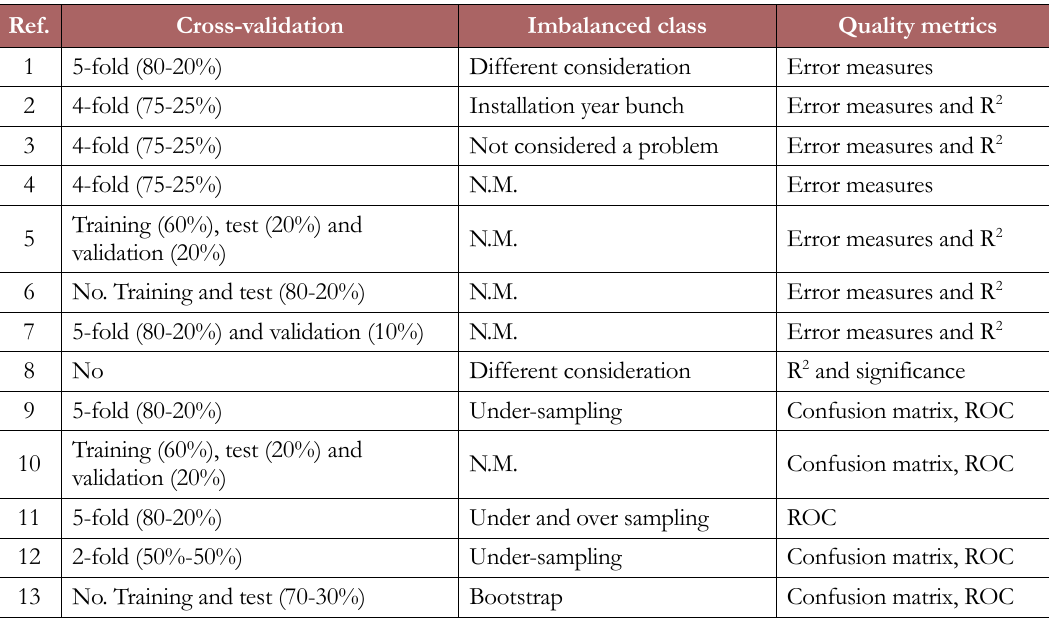
Table 3. Aspects of the training and validation phases of each study